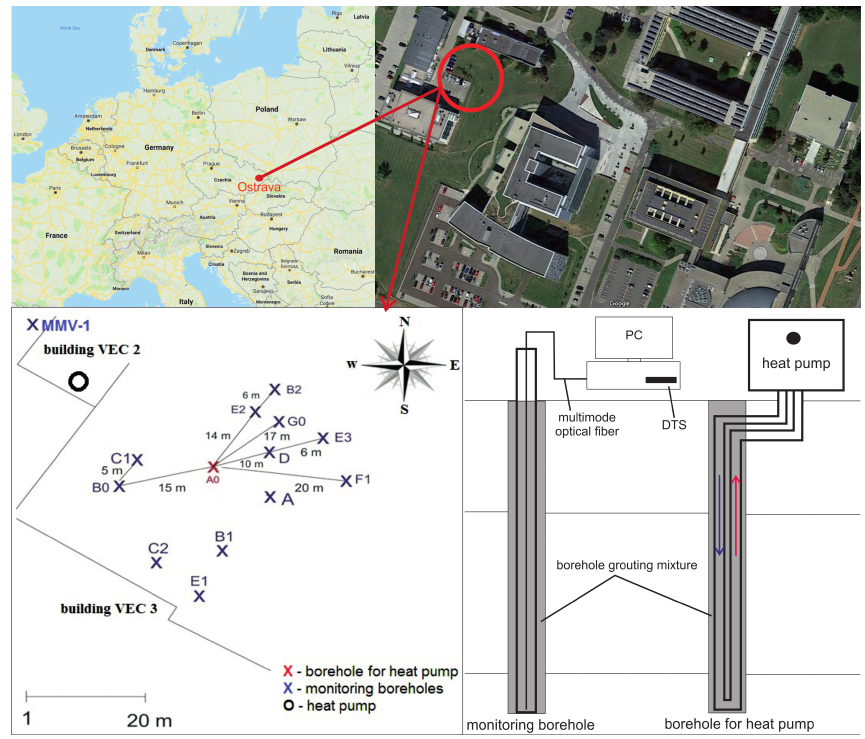
Figure 1. Location of boreholes in the Small Research Polygon geothermal